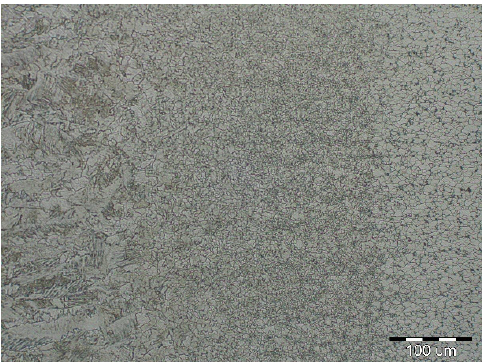
Figure 9. Microstructure of a narrow thermally affected area with a characteristic change in grain size in the recrystallization zone (HSLA).